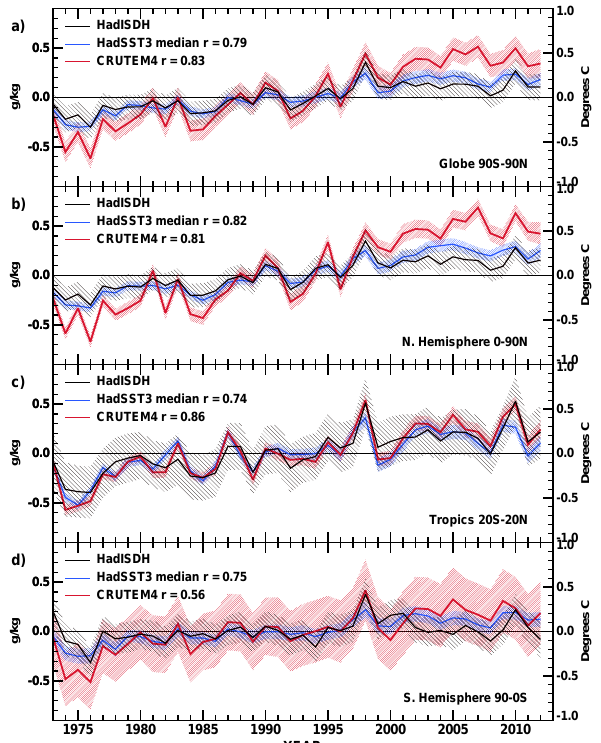
Fig. 13. Comparison of large-scale annual average time series from HadISDH land specific humidity with land surface air temperature from CRUTEM4 (Jones et al., 2012) and sea surface temperature from HadSST3 (Kennedy et al., 2011a, b), including uncertainty ranges. Temperature data have been adjusted to have a zero mean over the 1976–2005 climatology period of HadISDH. Correlations between the land air temperature and SST and land surface humidity have been performed on the detrended time